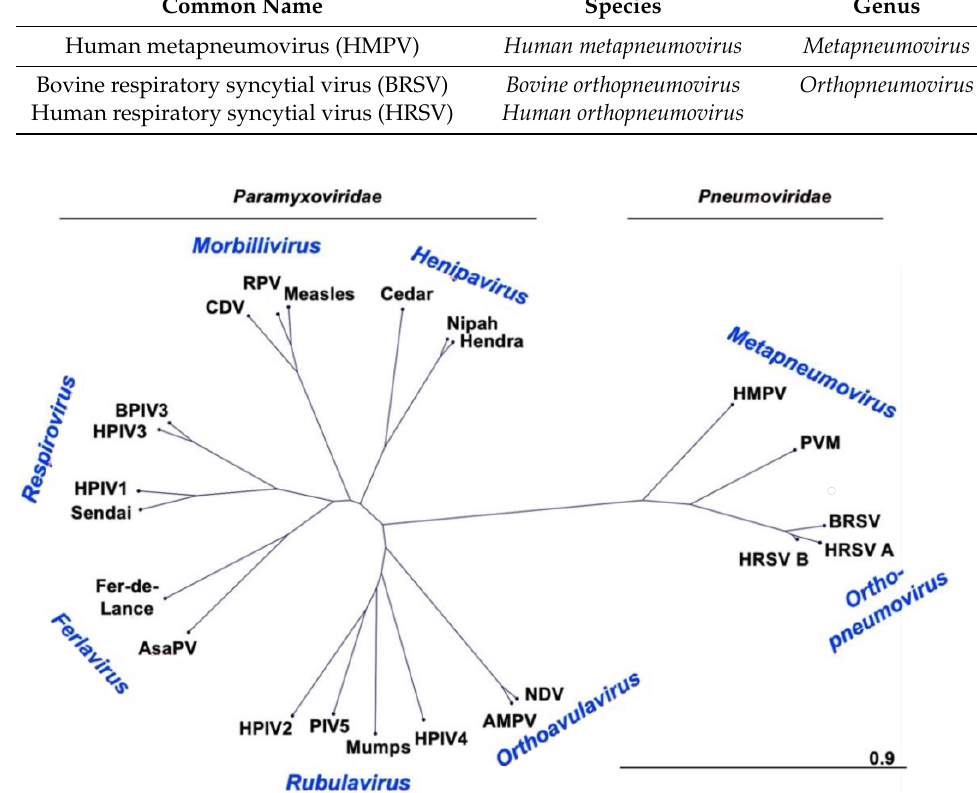
Figure 1. Phylogenetic tree of F proteins. Phylogenetic tree was created with CLC Main Workbench Version 20. Scale bar represents branch length as substitutions per site. CDV (canine distem-